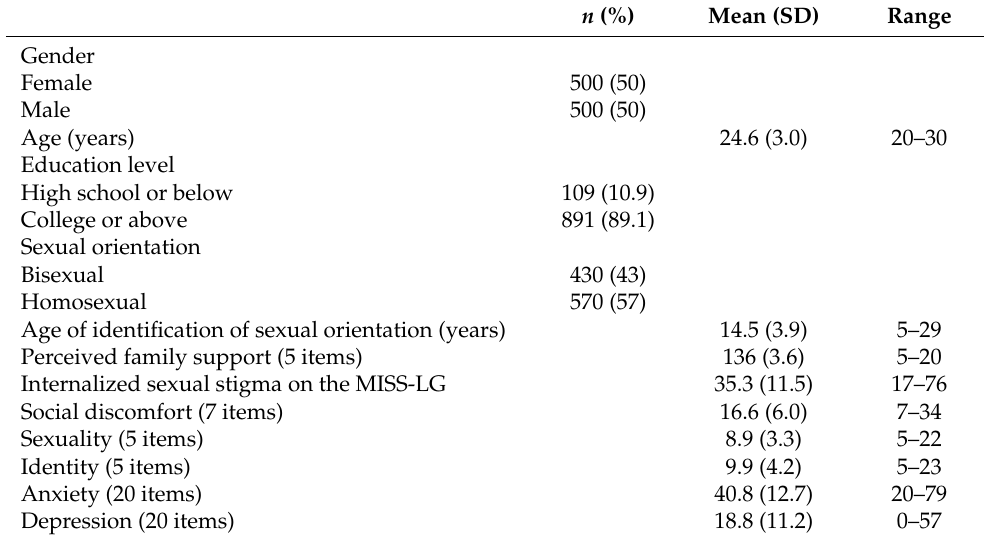
Table 1. Participants’ characteristics ( N =